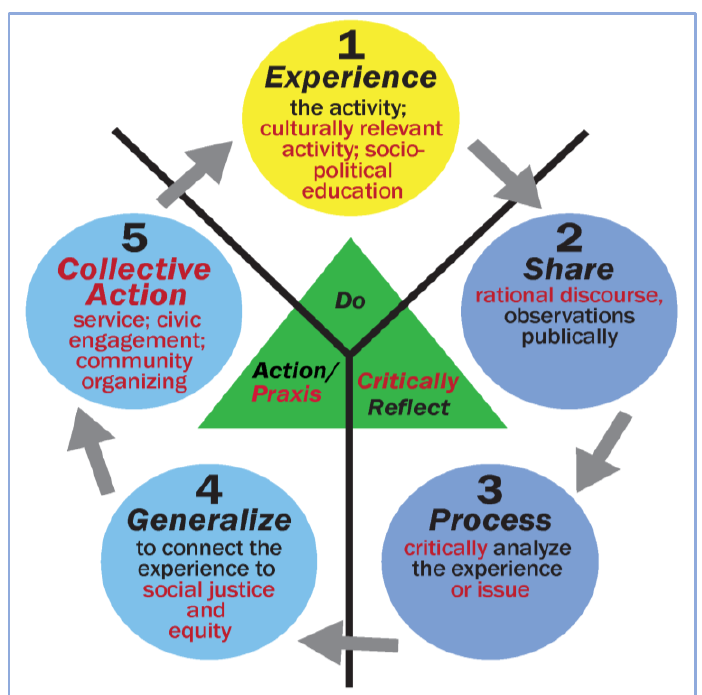
Figure 3. 4-H Critical Experiential Learning Model (Fields,